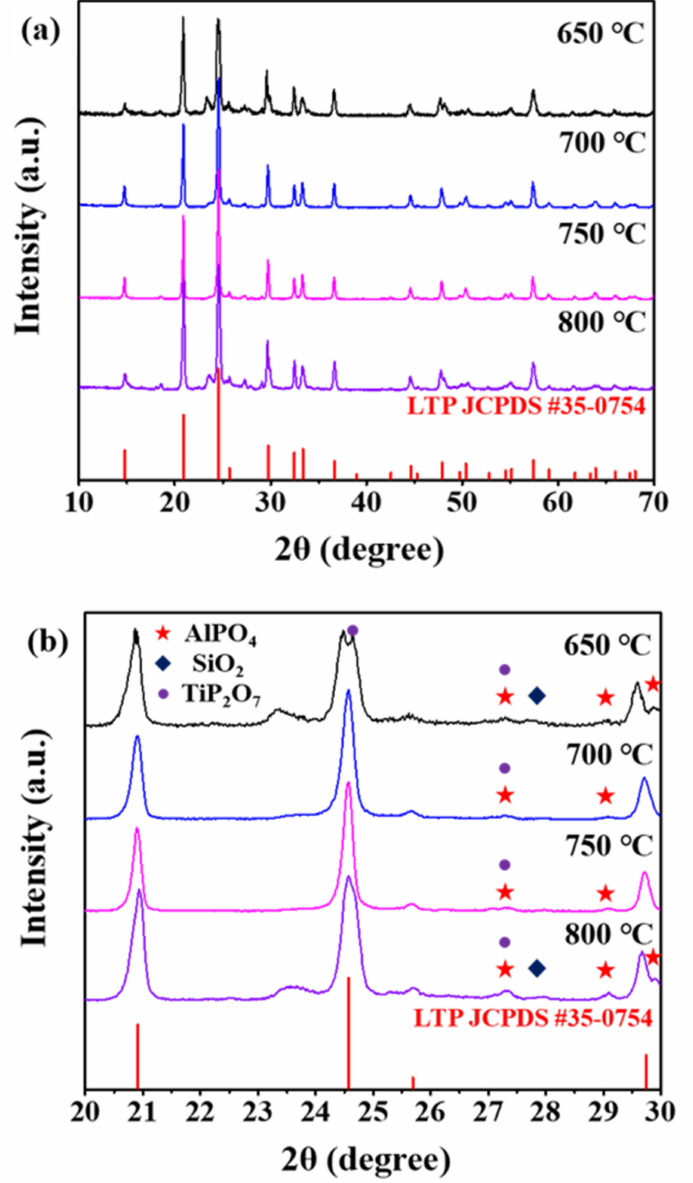
Figure 2. XRD patterns of ( a ) the LASTP-X powder calcined at various temperatures along with standard LTP JCPDS card and ( b ) rocking curves from 20 ◦ to 30 ◦